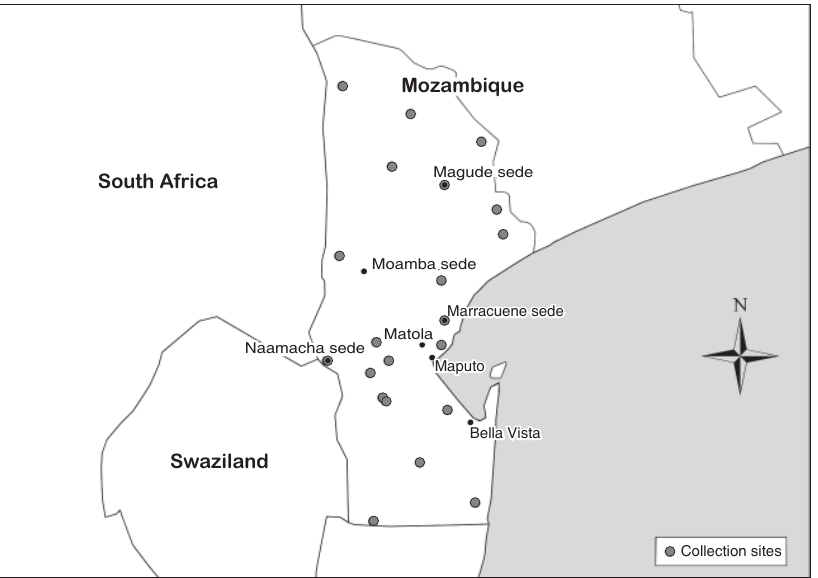
FIG. 1 Twenty-one localities in Maputo Province, Mozambique at which ticks were collected